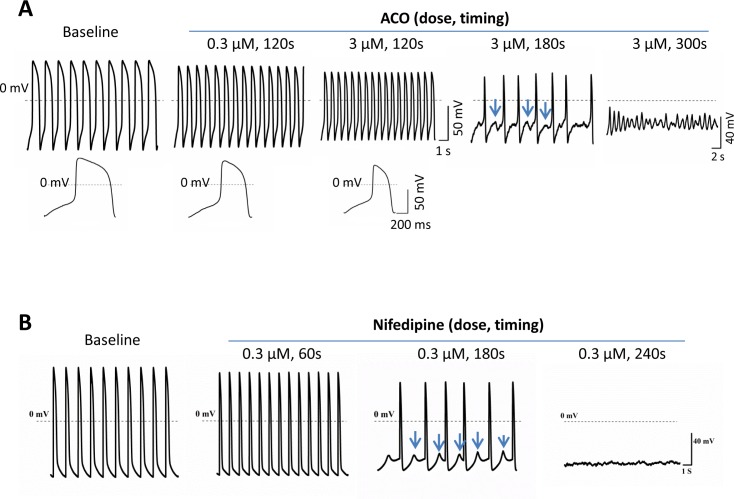
Effects of ACO on action potentials of hiPSC-CMs.(A) Representative AP waveforms recorded in a hiPSC-CM with 120 seconds (s) exposure of ACO at 0.3 and 3.0 μM and 180s and 300s exposure of ACO at 3.0 μM. Increased beating frequencies and decreased APD and APA were observed with short-term (120s) ACO treatment. Prolonged treatment of ACO at 3.0 μM led to frequent DADs and rapid irregular VF-like AP changes. (B),Representative AP waveforms recorded in a hiPSC-CM exposed to 0.3 μM nifedipine for 60s ~ 240s. Increased beating frequencies and decreased APD occurred at 60s while DADs emerged at 180s. APs were suppressed at 240s. The arrows indicate DADs.